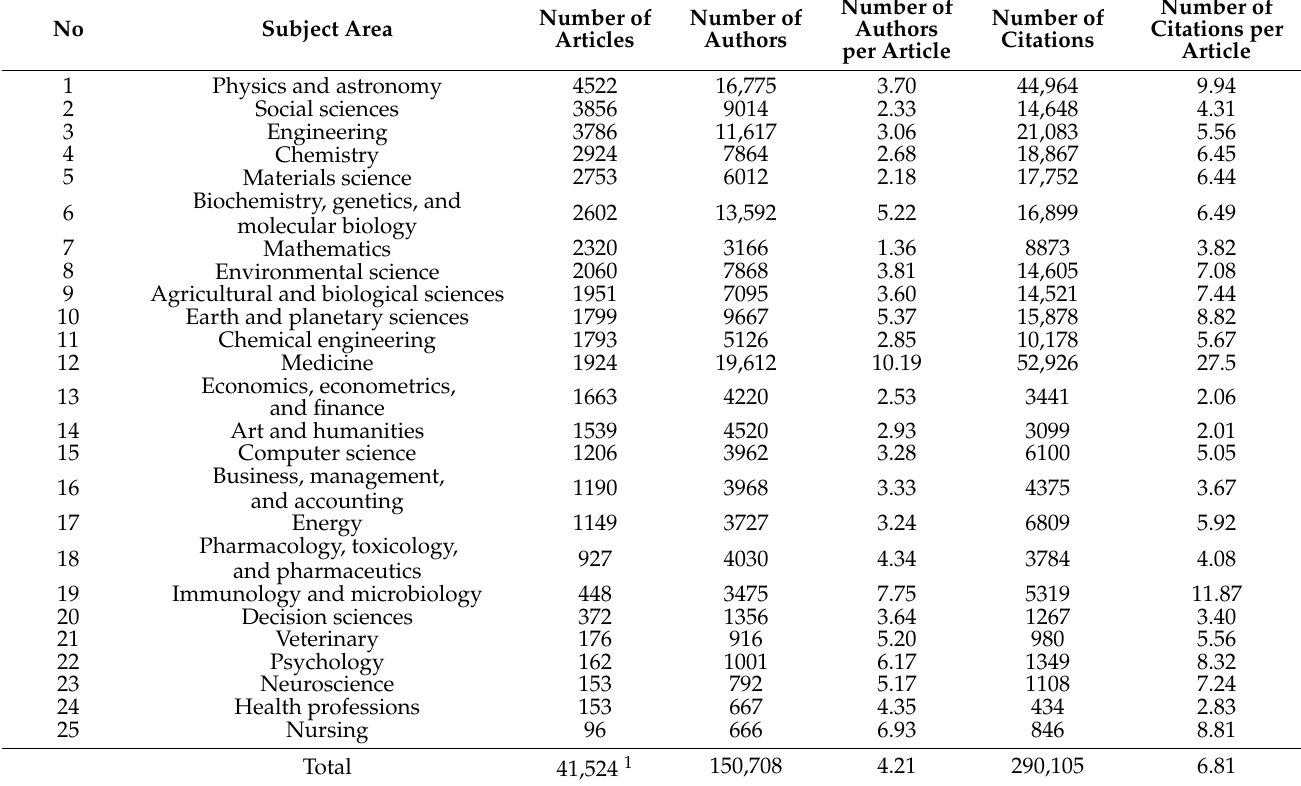
Table 2. Distribution of the number of articles, authors, and citations by subject